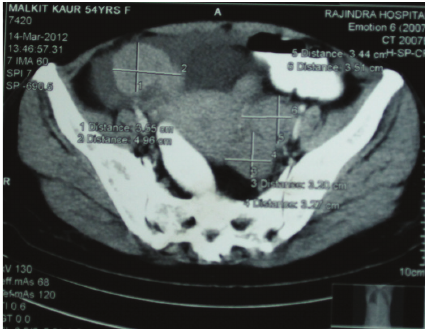
Figure 1: CT showing multiple heterogeneously enhancing masses in the pelvic around the uterus.